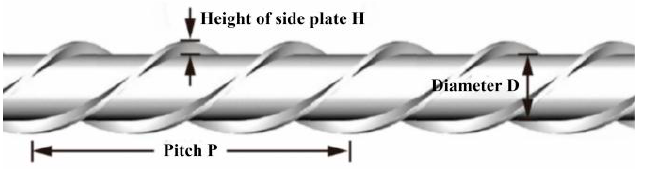
Figure 15. Schematic diagram of the geometric dimensions of spiral helical strakes.